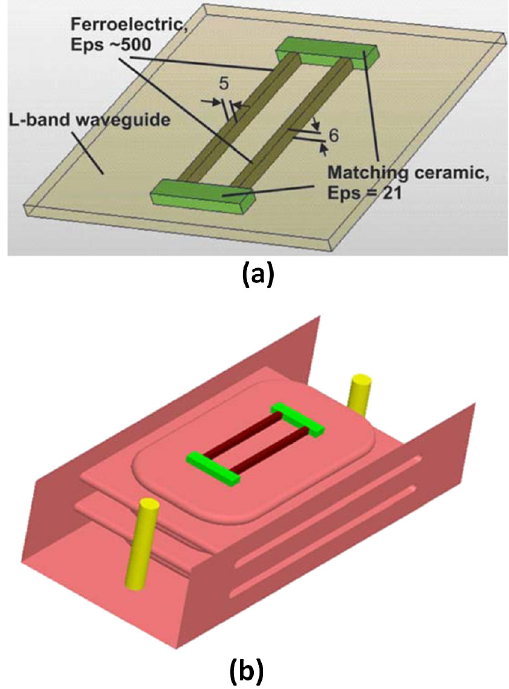
FIG. 5. (a) Arrangement for one set of FE bars (dark green) and ceramic slabs (light green); dimensions are in mm. (b) WR650 waveguide with top removed to show three ‘‘sand- wiches’’ and matching rods.